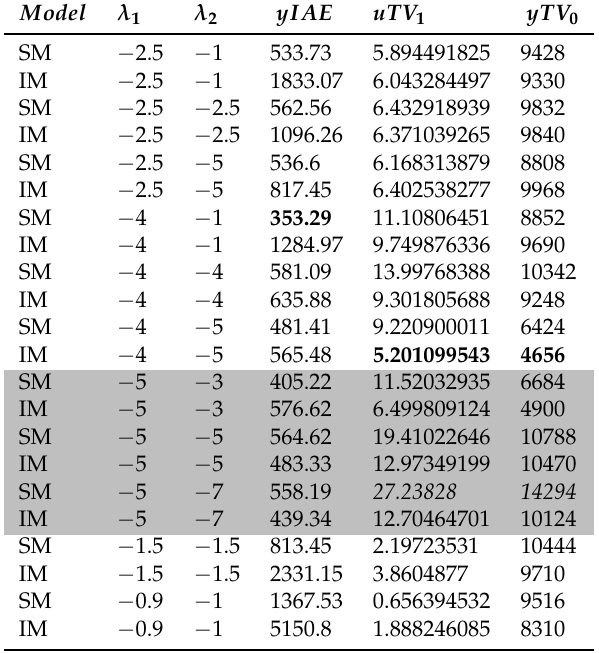
Table 1. Performance measures—Setpoint step (SM: static model (10), IM: integrating model (11), λ 1 : P controller closed loop pole, λ 2 : observer pole).